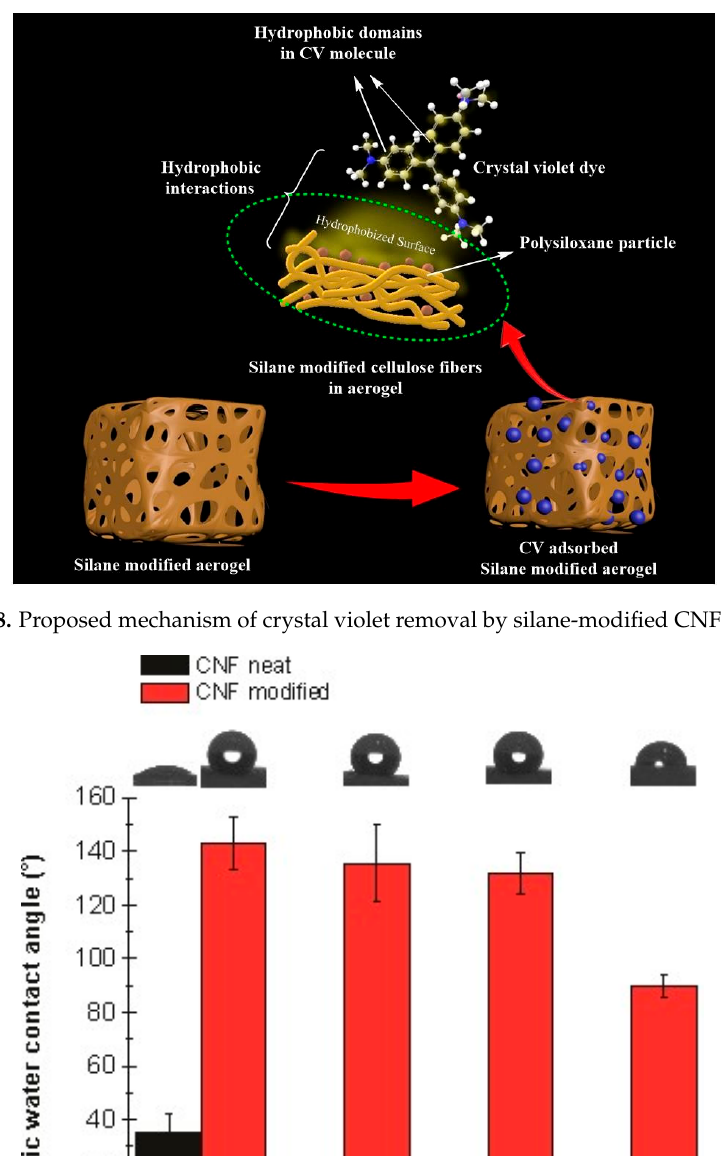
Figure 7. Adsorption capacity of silane-modified CNF aerogel against crystal violet dyes.